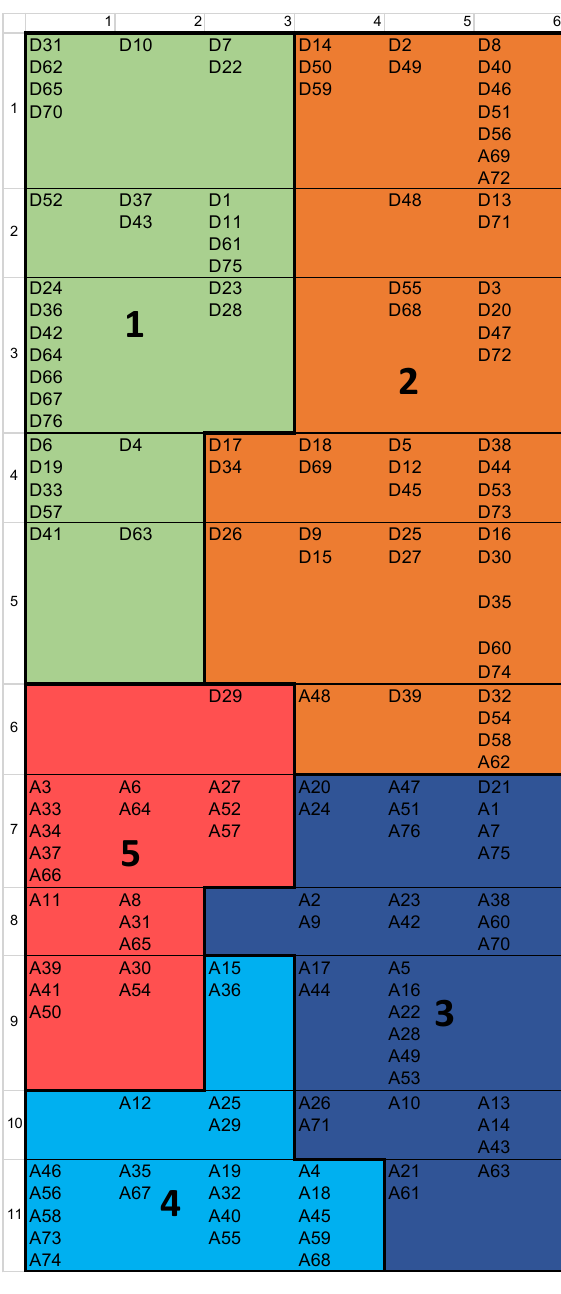
Figure 3. Value of (cid:1843)